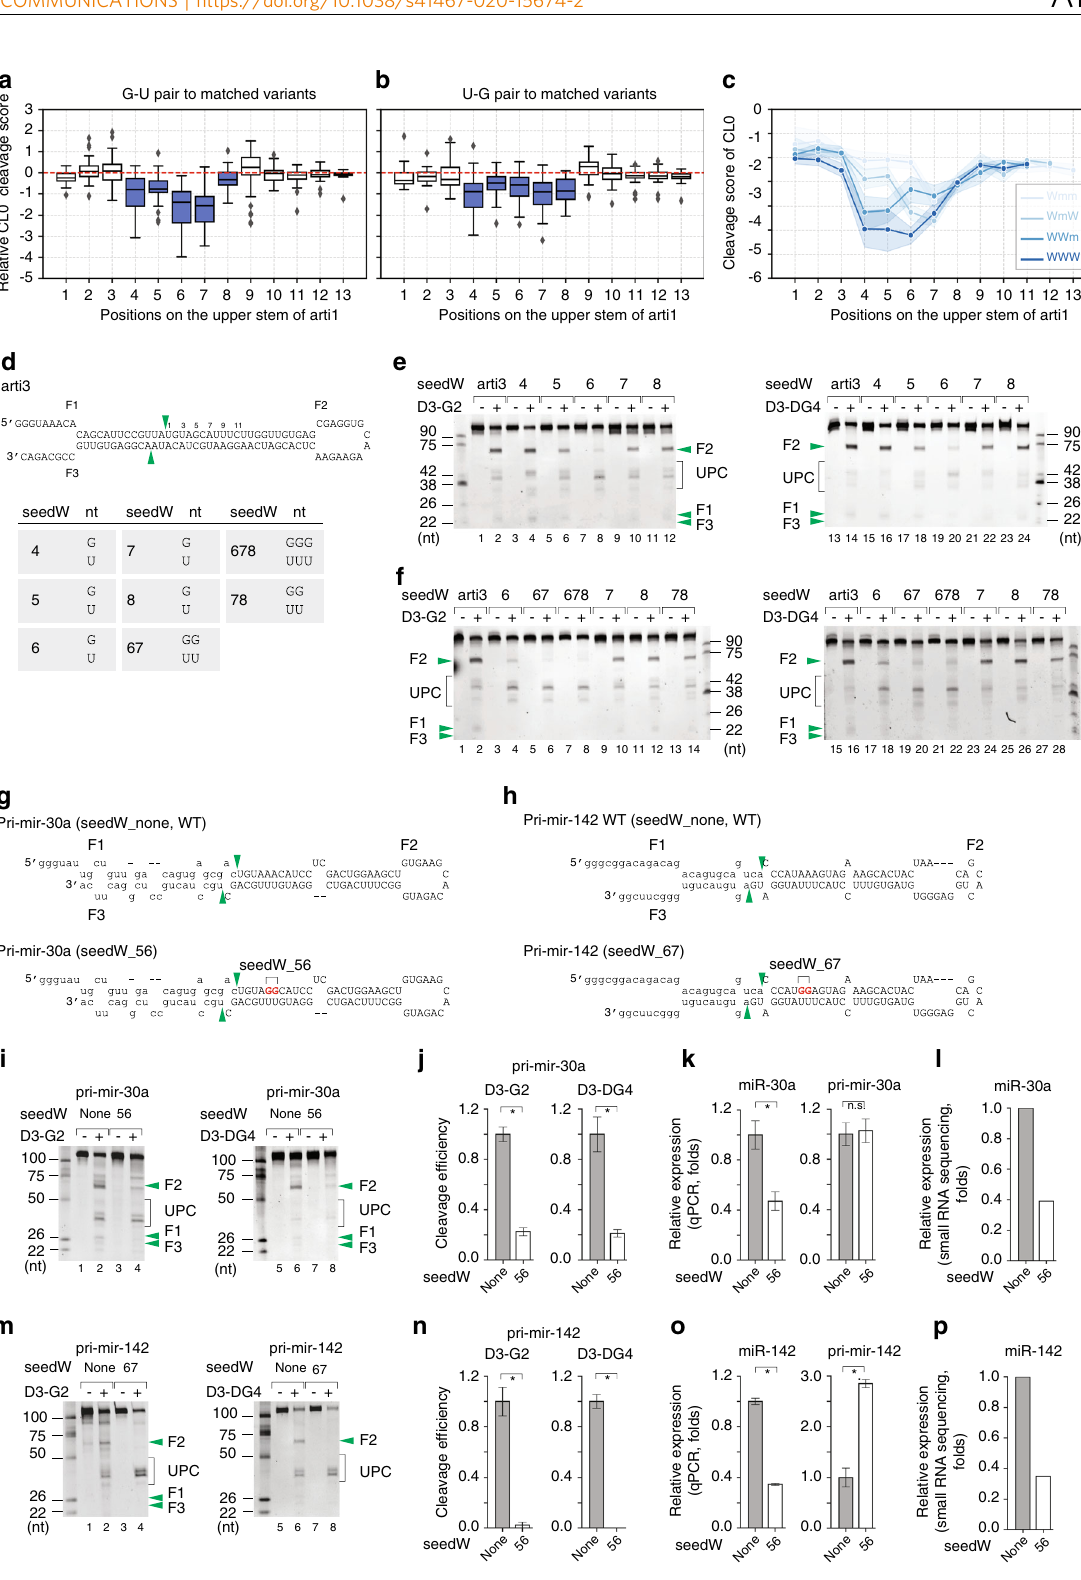
sample. The processing reaction was carried out at 37°C for 120 min, after which the control and reaction samples of each group were separated by 10% urea-PAGE. The original substrate from the control samples, the uncleaved substrate and the cleaved product (i.e., the F2-3 fragment) from each RNA group were separately